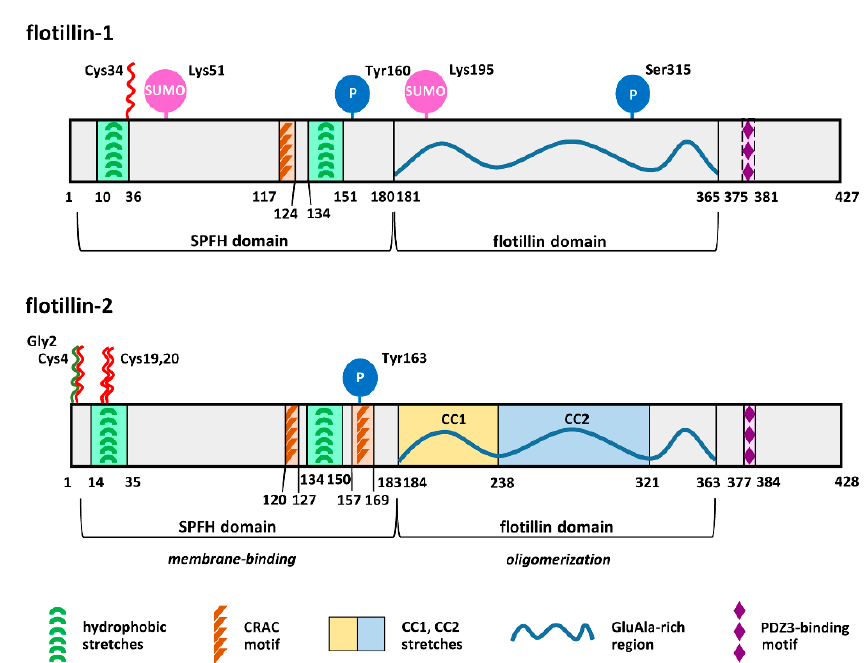
Figure 1. Structure of human flotillin-1 and flotillin-2: Amino acid sequences of human, mouse, and rat flotillin-1 are at least 97.9% identical, and those of flotillin-2 are at least 99.3% identical. The SPFH and flotillin domains are indicated according to References [59,60,62]. The PDZ3-binding domain is better conserved in flotillin-2 than in flotillin-1 [59]. Flotillin-1 and -2 possess, respectively, nine and eight potential sites of tyrosine phosphorylation [8]. Phosphorylation of Tyr160 and Tyr163 by